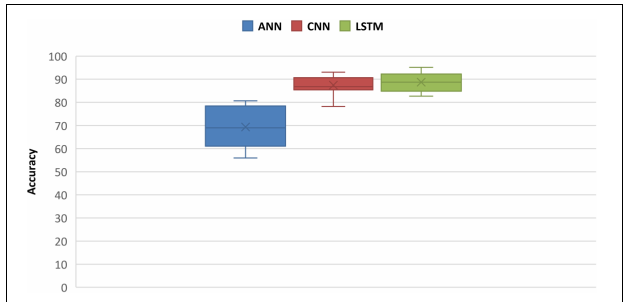
FIGURE 12 | Box plot comparison between ANN, CNN, and LSTM classification